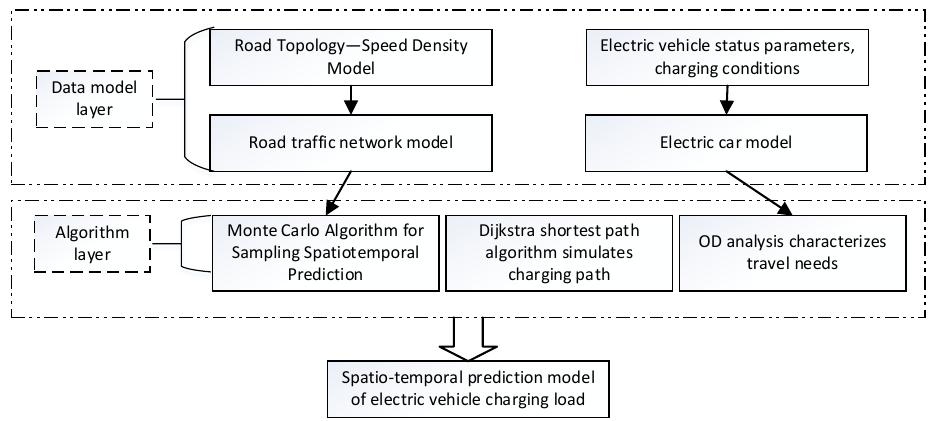
Figure 4. Space-time prediction frame structure of electric vehicle charging load.